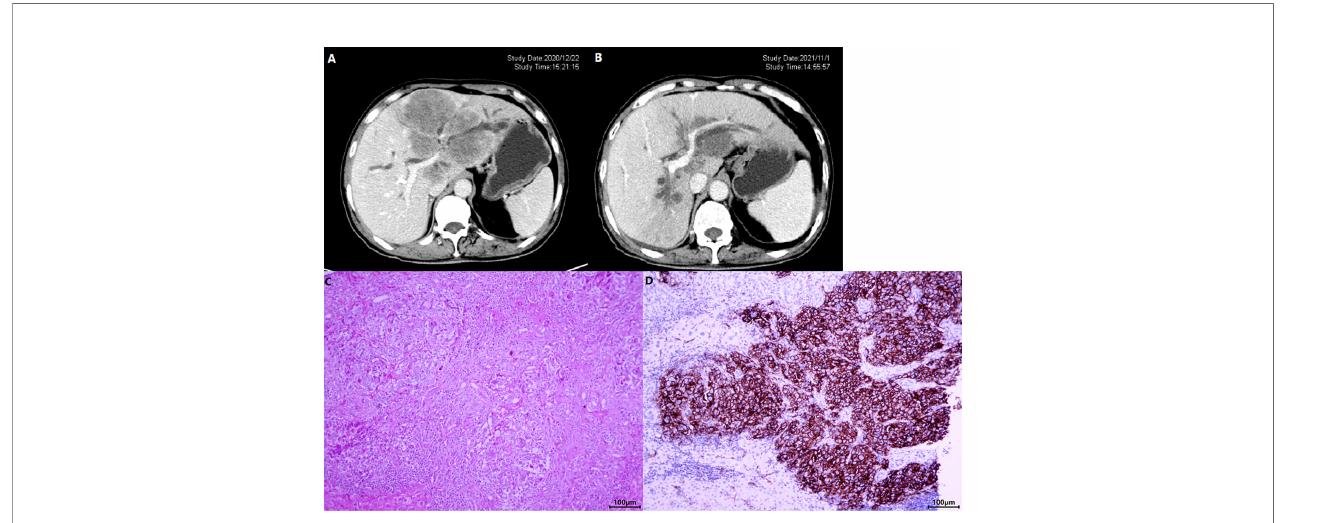
FIGURE 4 | A patient with iCCA received lenvatinib+sintilimab as 2nd-line systemic therapy. The CT images before (A) and after (B) nearly 1-year therapy showed a signi fi cant shrinkage of the target lesion, which was mainly located in the left hemi-liver and invaded the left branch of portal vein. (C) Shows the HE staining of the tumor and (D) displays the photomicrographs of immunohistochemistry staining of PD-L1 expression.